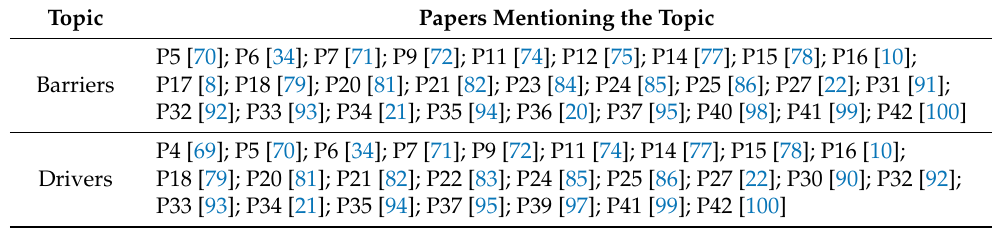
Table 10. Papers mentioning barriers and drivers.